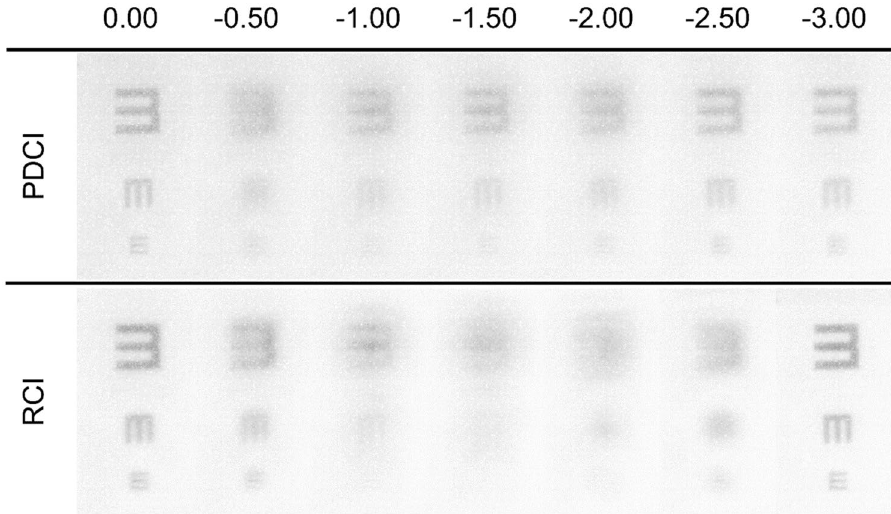
Figure 4. Images of a tumbling E optotype corresponding to 0.4, 0.2 and 0 logMAR VA obtained the VAO system simulating the PDCI and RCI with the object at different vergences from 0.0 D to − 3.0